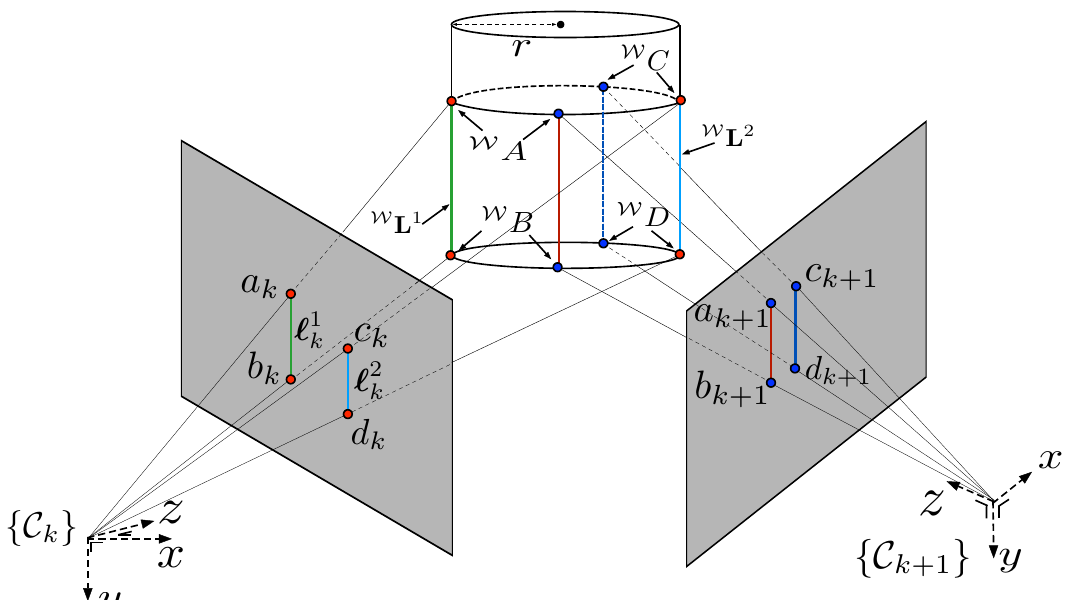
R 3 denote points ∈